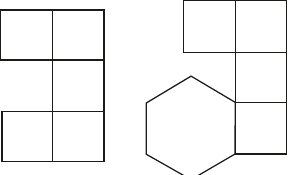
Figure 3: Internal segment consisting of a hexagon and a square and contains an edge connecting vertices of degree 3.